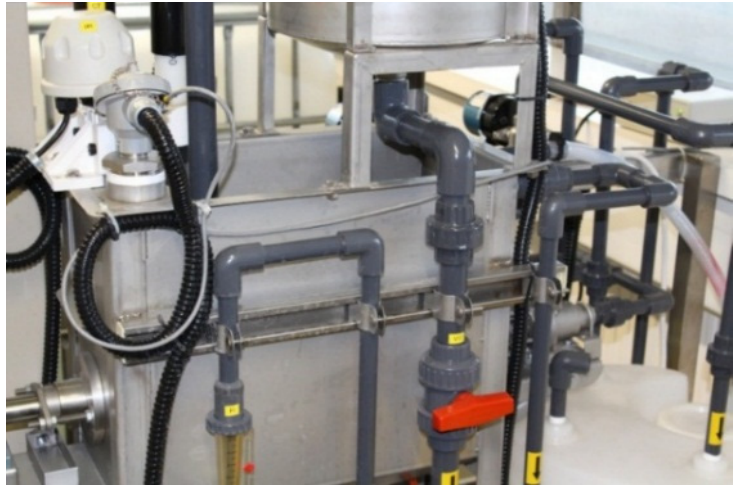
Figure 3. Partial picture and set-up of the rotating membrane bioreactor (MBR) system RPU-185 (Avanti Membrane Technology, Walnut, CA, USA) in operation. The membrane module is located in the batch tank for filtration purposes.